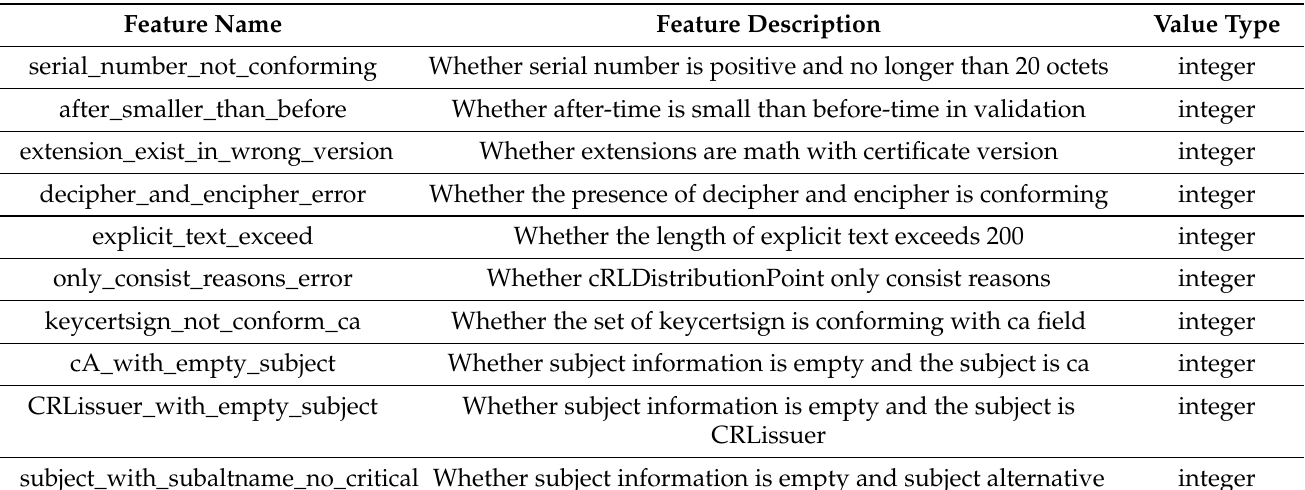
Table 5. Details of features from standard